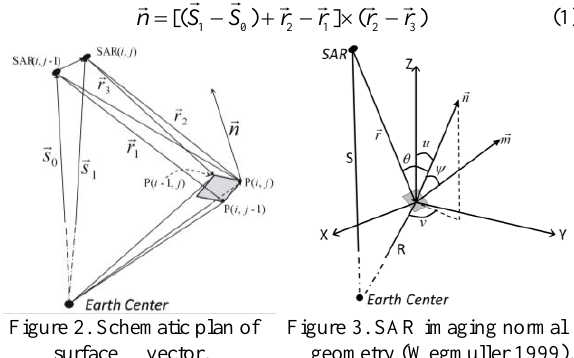
Figure 1. Flowchart of the DEM coregistration method based on the SAR imaging geometry